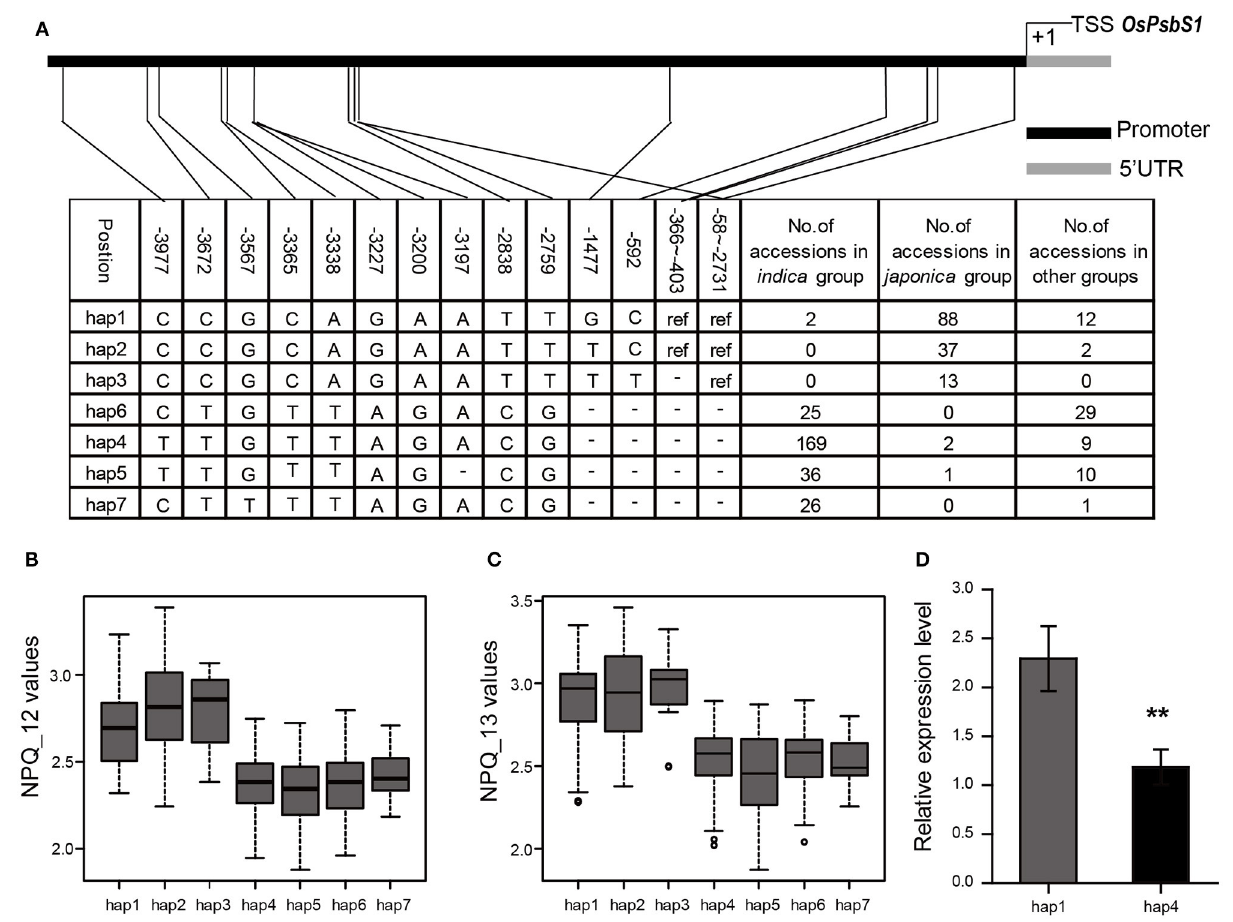
FIGURE 2 | Haplotype analysis of the OsPsbS1 promoter region in the 480 accessions. (A) Seven haplotypes (hap1-hap7) were detected. The 4,022-bp promoter region is shown in graphics on the top. The position of every SNP is shown in the first row. The number of accessions in each haplotype is shown in the right columns. Ref, sequence identical to Nipponbare; –, sequence deleted. (B) The distribution of NPQ_12 values in the seven haplotypes. (C) The distribution of NPQ_13 values in the seven haplotypes. (D) The transcript levels of OsPsbS1 in flag leaves of hap1 and hap4 accessions. **The differences in expression levels between hap1 and hap4 are significant at P <